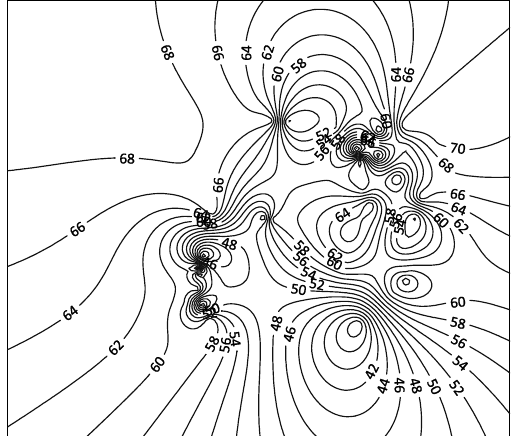
Figure 3. Distribution of the rock compressive strength values expressed in MPa in the analyzed area. Reproduced from [36], Wyd. IGSMiE PAN: 2007.